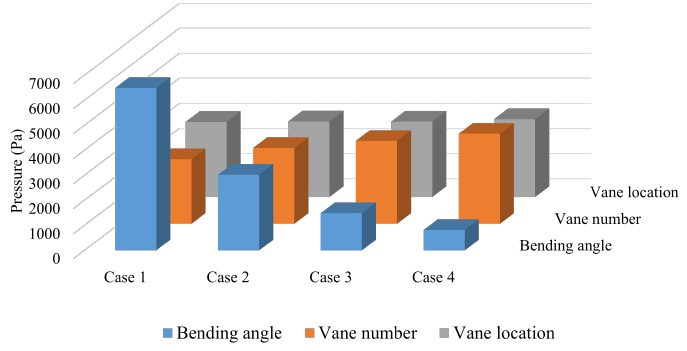
Figure 20. Comparison of different structure effects on pressure